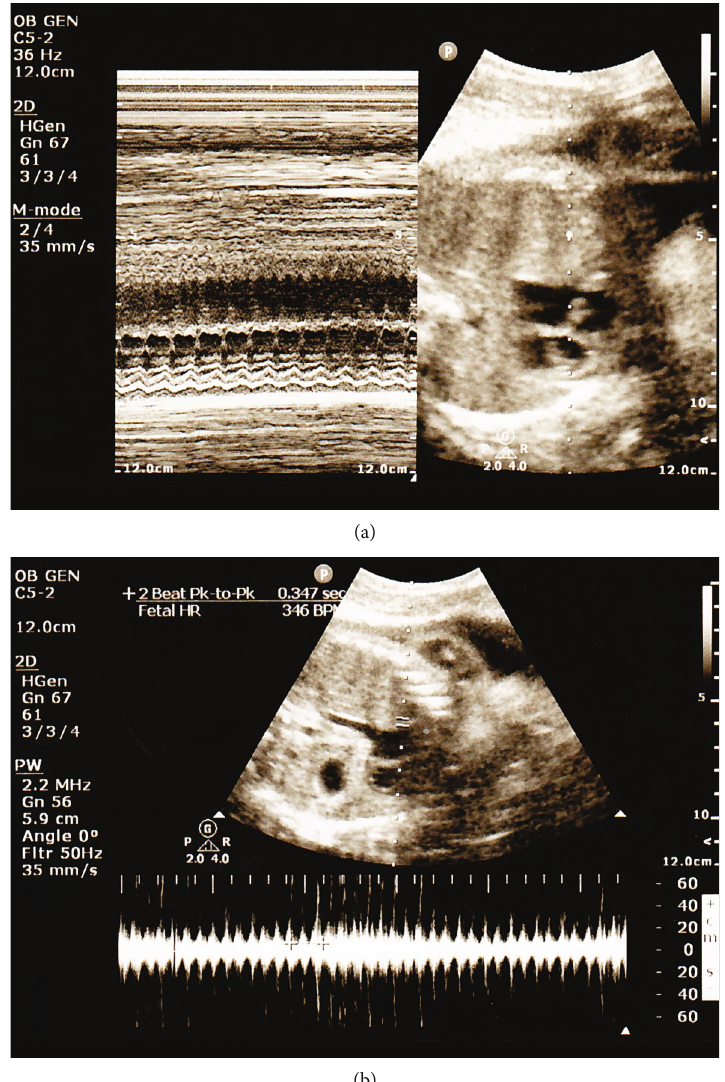
Figure 1: Bedside ultrasound on day of admission, demonstrating fetal tachycardia on (a) M-mode and (b) spectral Doppler